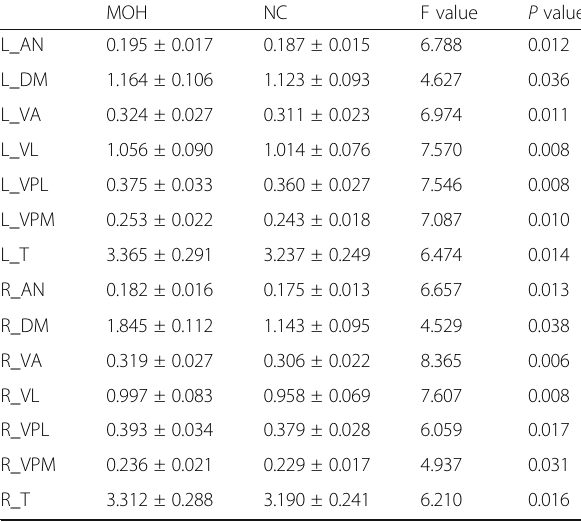
Table 2 The volume comparison of thalamic subnuclei(ml) between MOH and NC